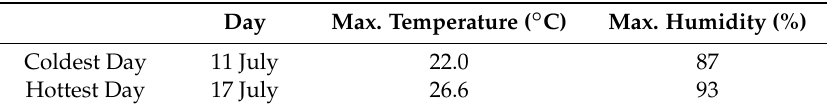
Table 2. Record of meteorological conditions.